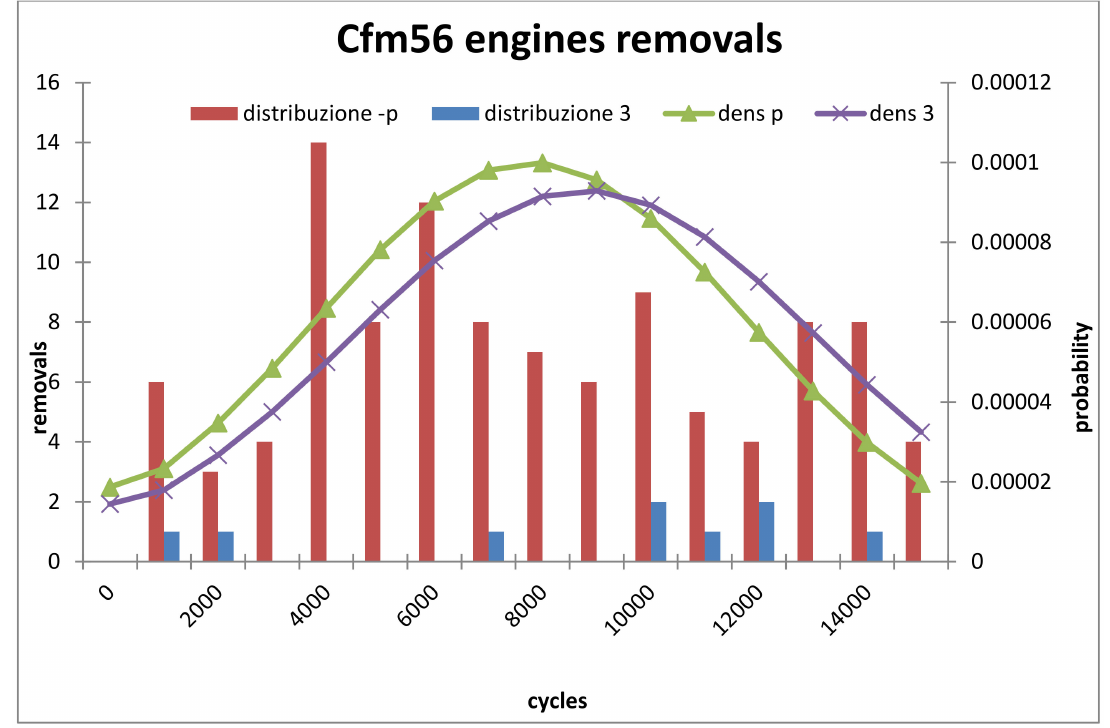
Figure 11. Time in cycles—removals